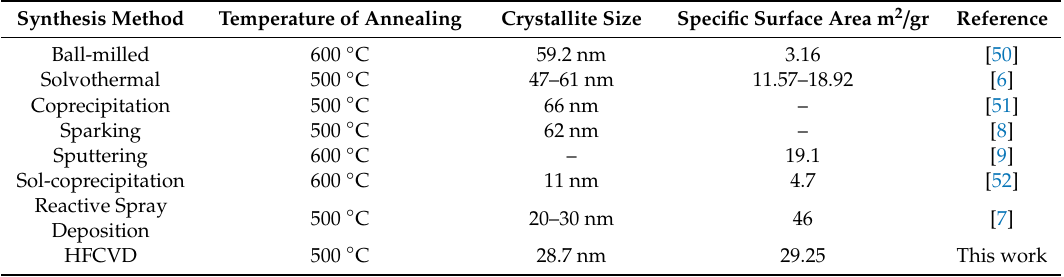
Table 3. Comparative data for crystallite size and SSA of tungsten oxide porous